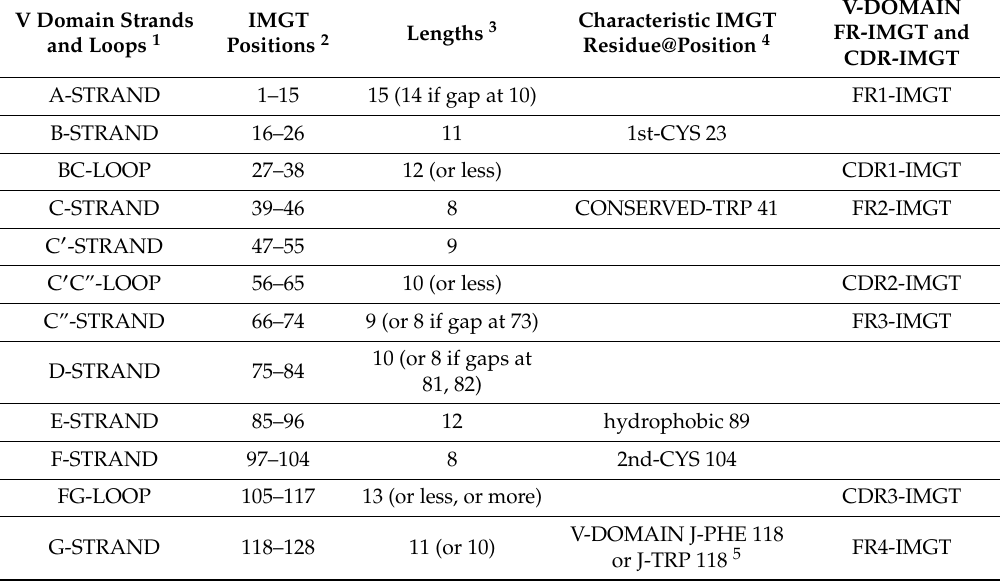
Table 10. V domain strands and loops and IMGT positions and lengths, based on the IMGT unique numbering for V domain (V-DOMAIN and V-LIKE-DOMAIN)